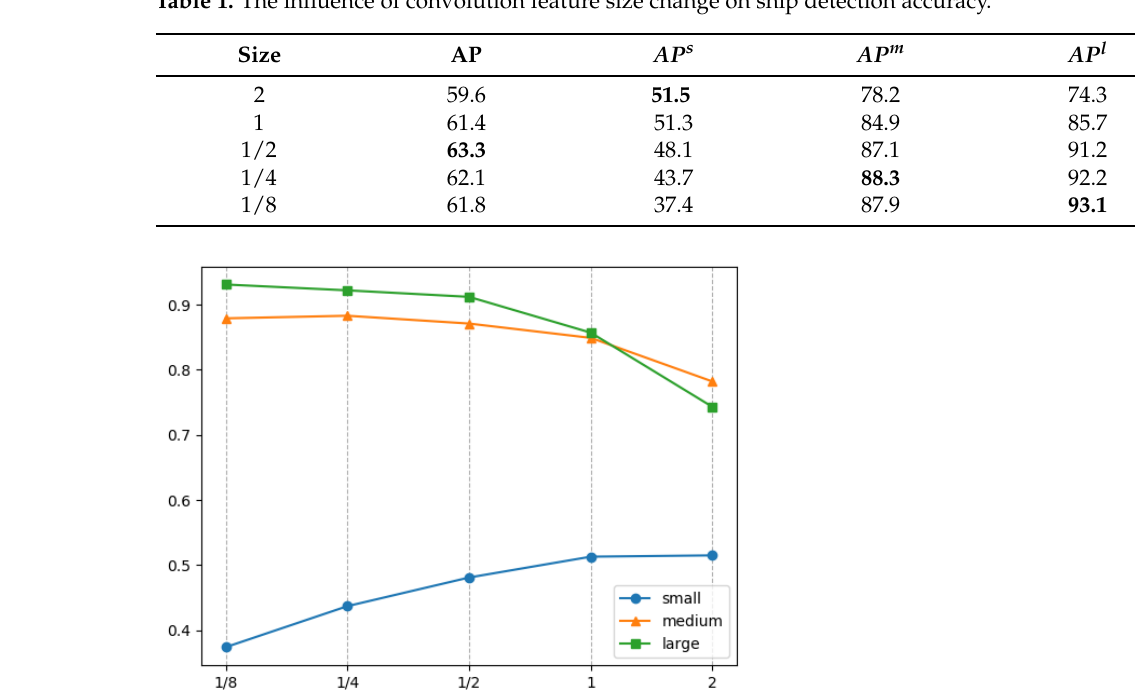
Figure 6. The detection accuracy of ship targets of different sizes is affected by changes in the convolution features’ size. Thse ordinate represents the AP value; the abscissa represents the size of the convolution feature, 1 represents 1 of the input image size, 1 represents the same size as the 2 2 input image, and 2 represents 2 times the input image